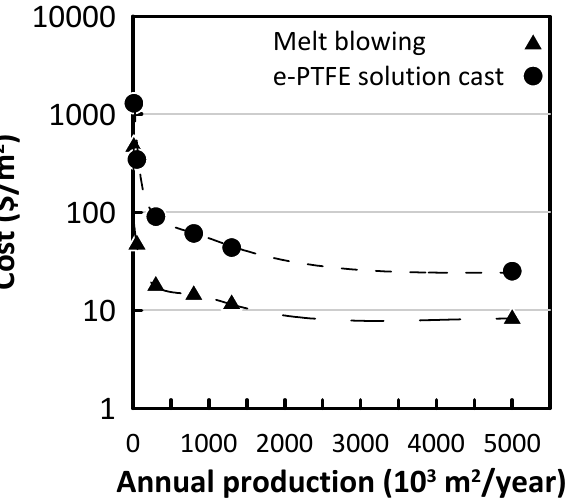
Figure 3. Cost estimation of perfluorinated sulfonic acid polymer electrolyte membrane produced by two different methods as a function of the total yearly production (data from [24]).